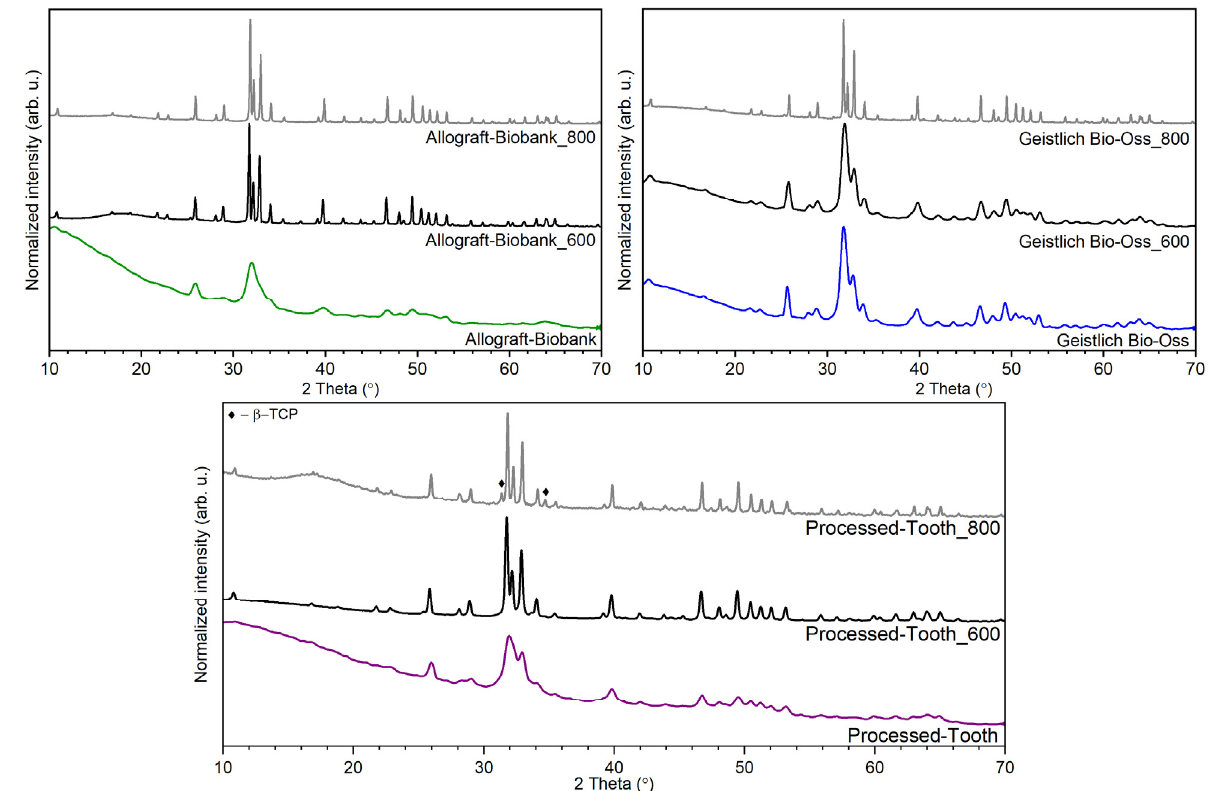
Figure 10. XRD patterns of heat-treated bone-reconstruction